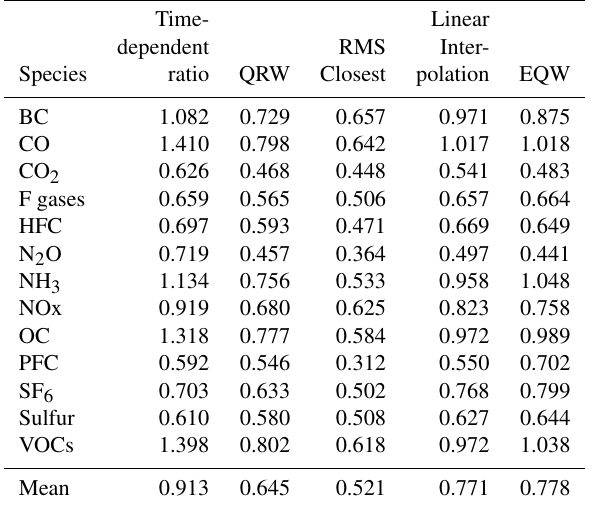
Table 5. Root mean squared error in reconstructing known data us- ing different crunchers, with CH 4 as the lead variable, normalised by the standard deviation at that